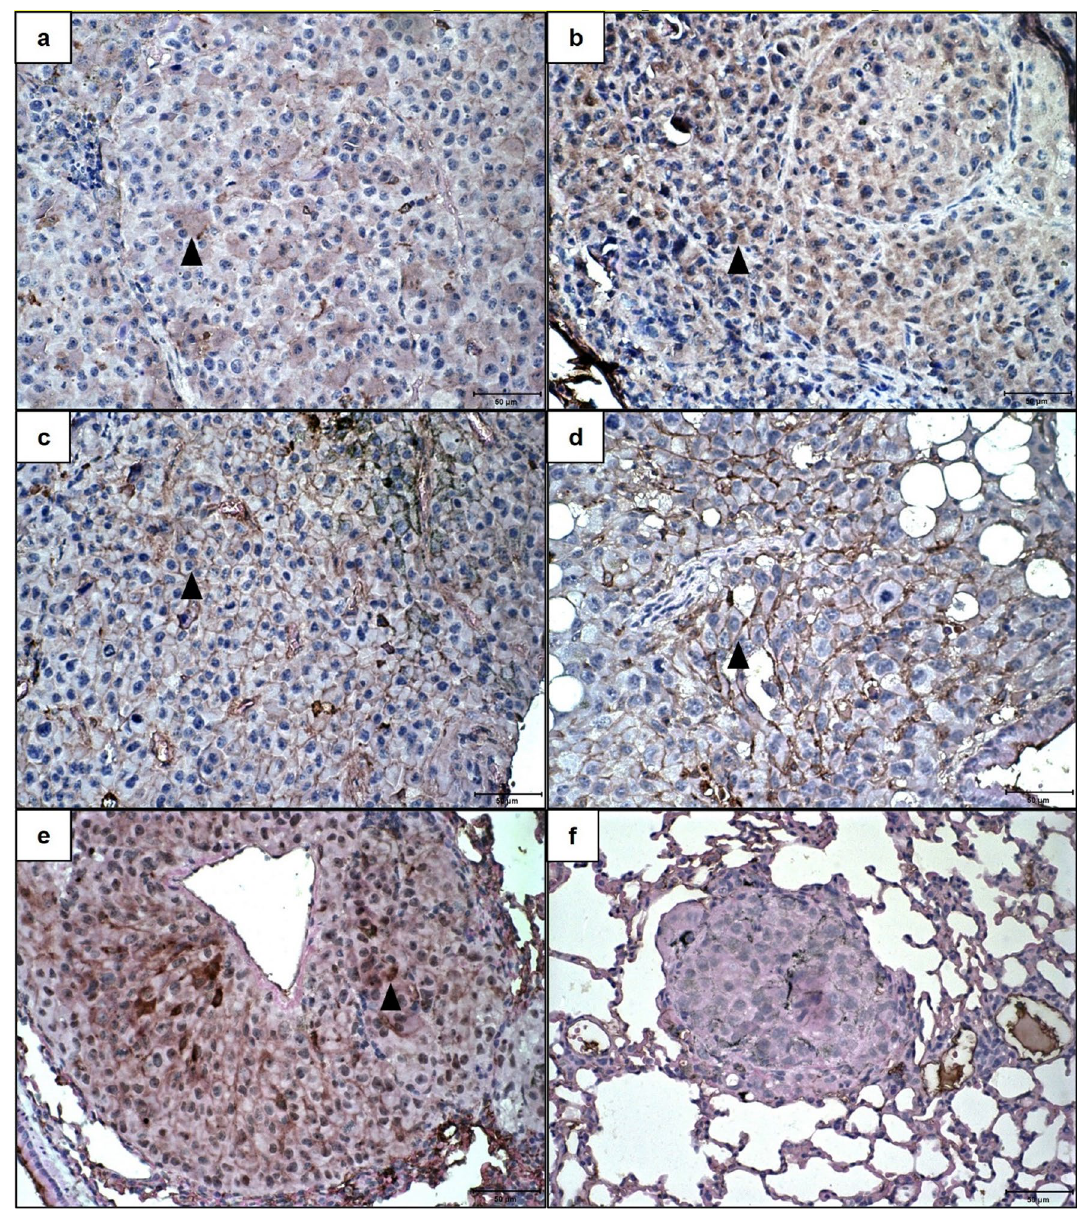
Figure 8. Immunohistochemical expression of Twist, ZEB1, and ZEB2 in lung metastases from C57BL/6 mice inoculated with metformin-treated or untreated B16-F10 cells. ( a , b ) Lung tissues showing cytoplasmic imunoexpression of Twist, 21 days after inoculation of B16-F10 cells: ( a ) untreated with metformin; ( b ) treated, in vitro, with 0.5 mM of metformin. ( c , d ) Lung tissues showing membrane imunoexpression of ZEB1 21 days after inoculation of B16-F10 cells: ( c ) untreated with metformin; ( d ) treated, in vitro, with 0.5 mM of metformin. ( e , f ) Lung tissues showing membrane and nuclear imunoexpression of ZEB2, 21 days after inoculation of B16-F10 cells: ( e ) untreated with metformin; ( f ) treated, in vitro, with 0.5 mM of metformin. ×40. Scale Bar: 50 µM. Arrowhead: Neoplastic cells with positive